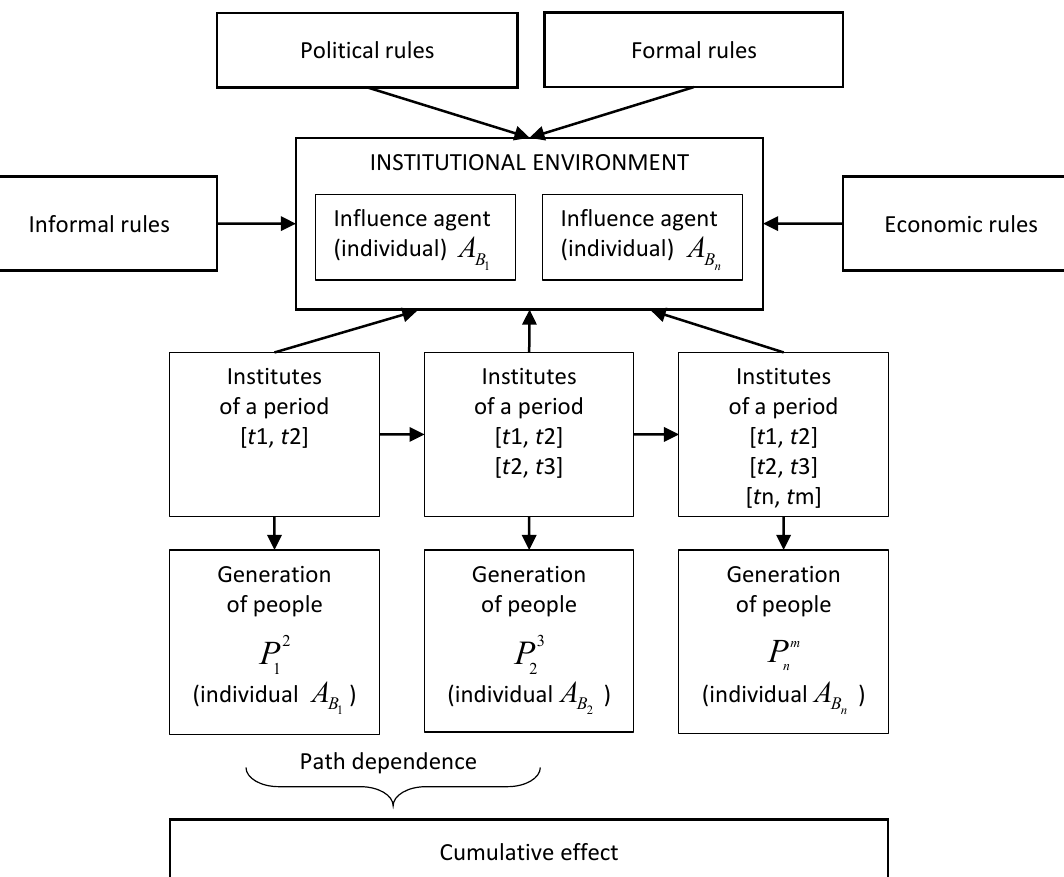
Figure 1. Shaping the institutional environment taking path dependence into